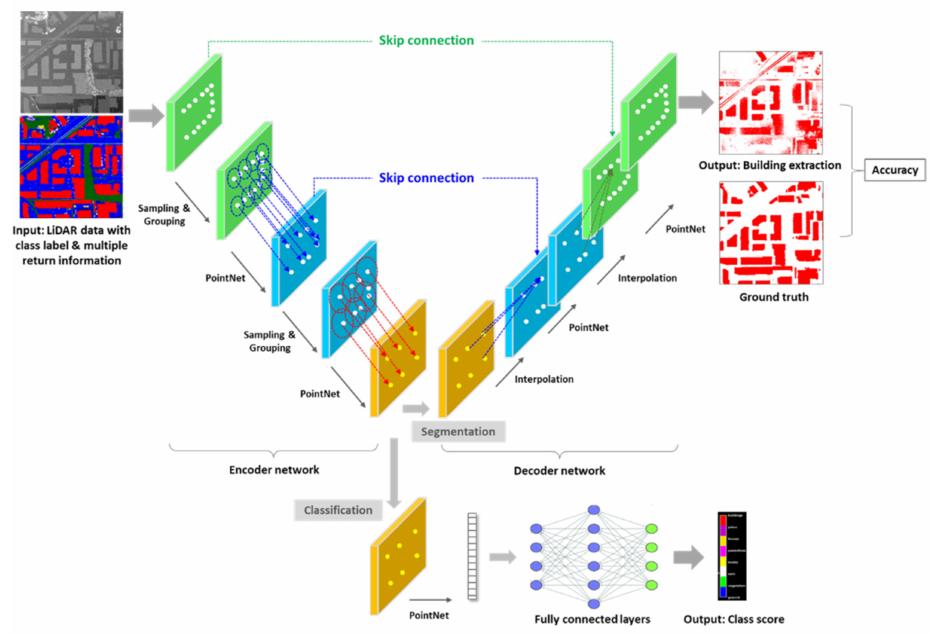
Figure 9. PointNet++ architecture for segmentation and classification.